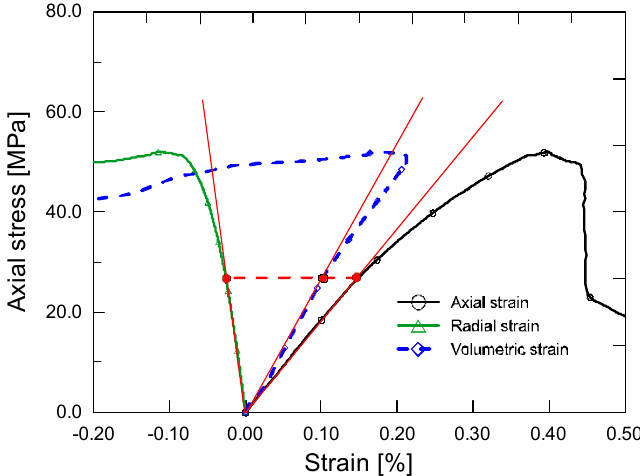
Figure 4. Illustration of the initial linear segments of stress–strain curves.